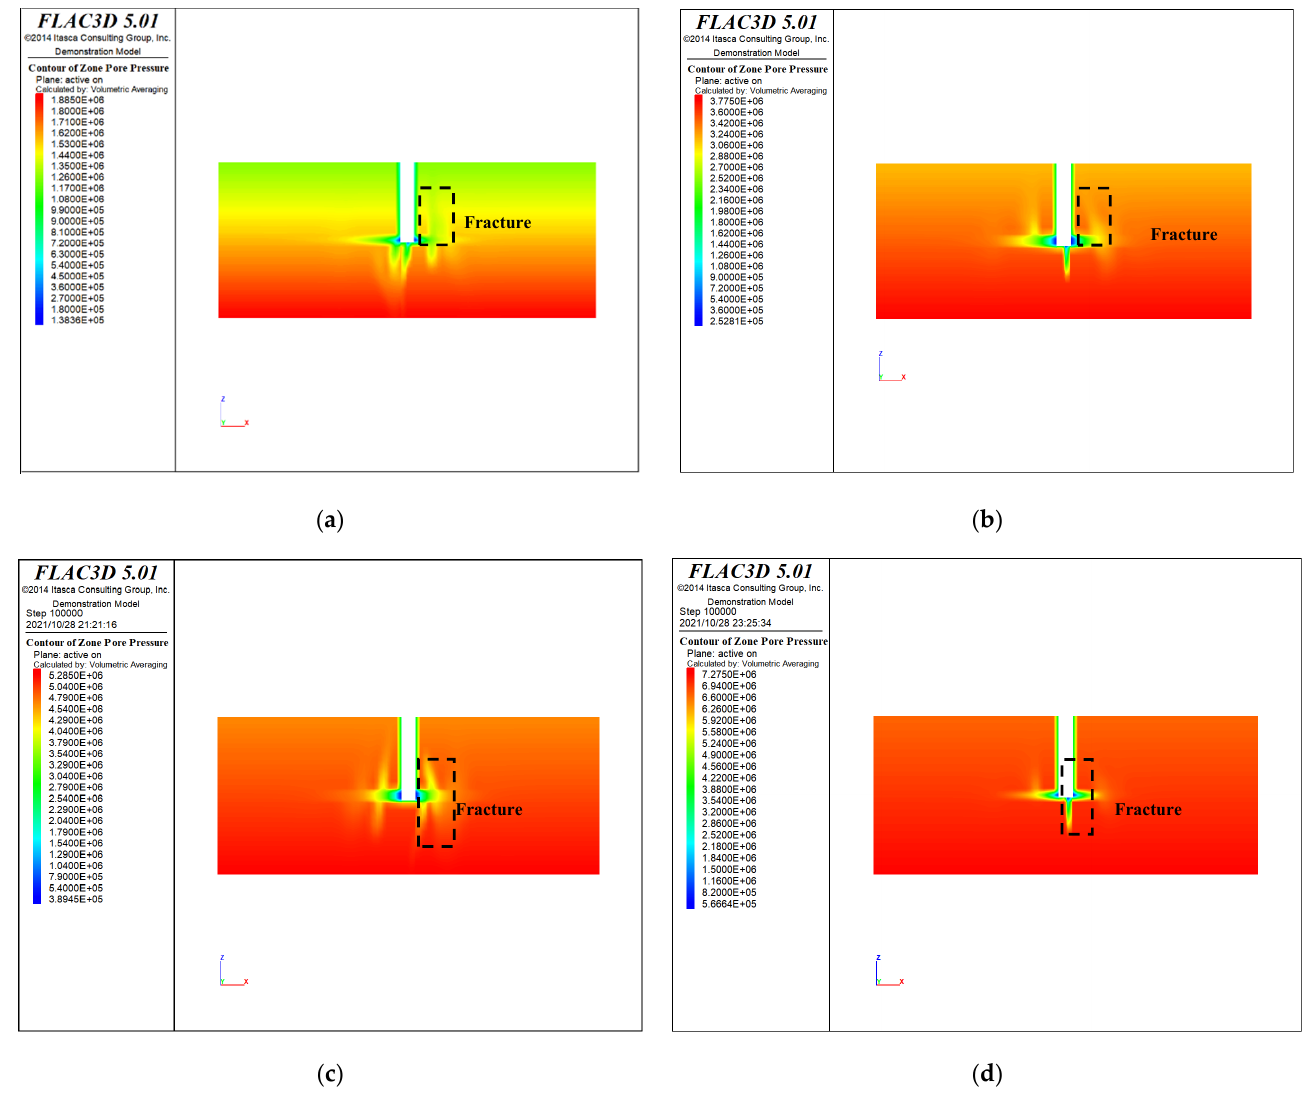
Figure 7. Hydraulic pressure field of different excavation sections without grouting. ( a ) Aq1, ( b ) Aq2, ( c ) Aq3, ( d ) Aq4. Table 5. Permeability coefficient values for different aquifers with grouting of No. 1